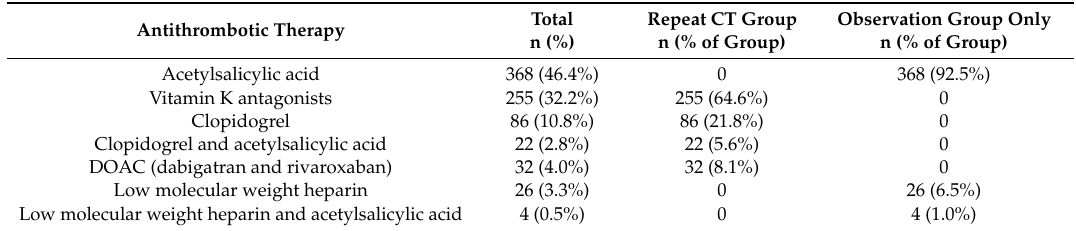
Table 1. Type and frequency of antithrombotic therapy in total and in the subgroups of the study. Antithrombotic